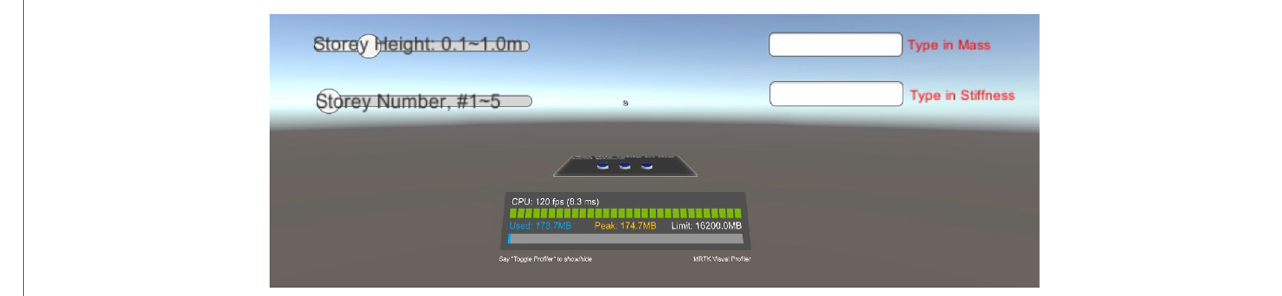
FIGURE 10 | AR application – fi nite element models.